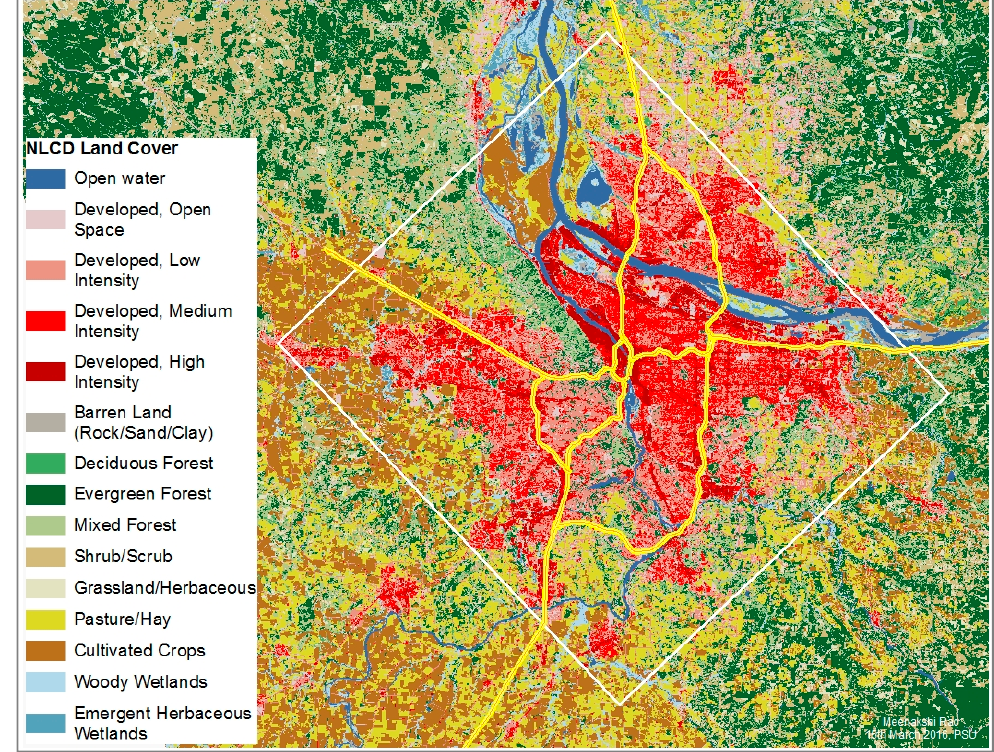
Figure 1. Land use in the Portland-Hillsboro-Vancouver area (based on NLCD 2011).